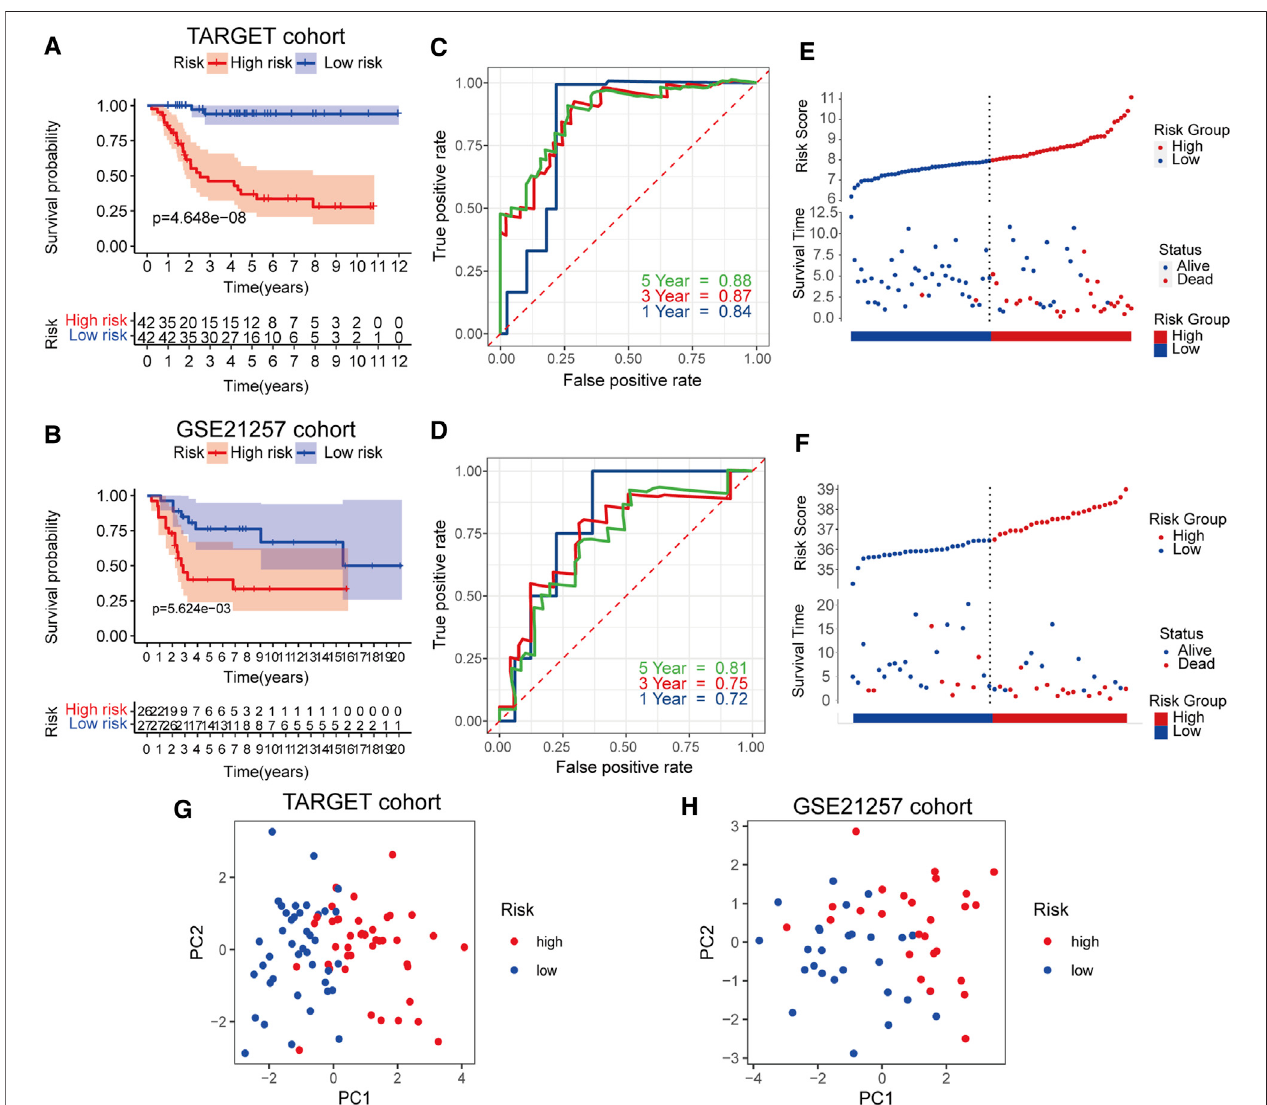
FIGURE 3 | Survival analysis of RBPs prognostic signature in TARGET cohort and validation in GSE21257 cohort (A,B) Kaplan-Meier curves in the two cohorts (C,D) Riskscoreanalysisofthesignatureinthetwocohorts (E,F) TheAUCforthepredictionof1,3,5 yearssurvivalrate (G,H) PCAbasedontheRBP-relatedsignature.